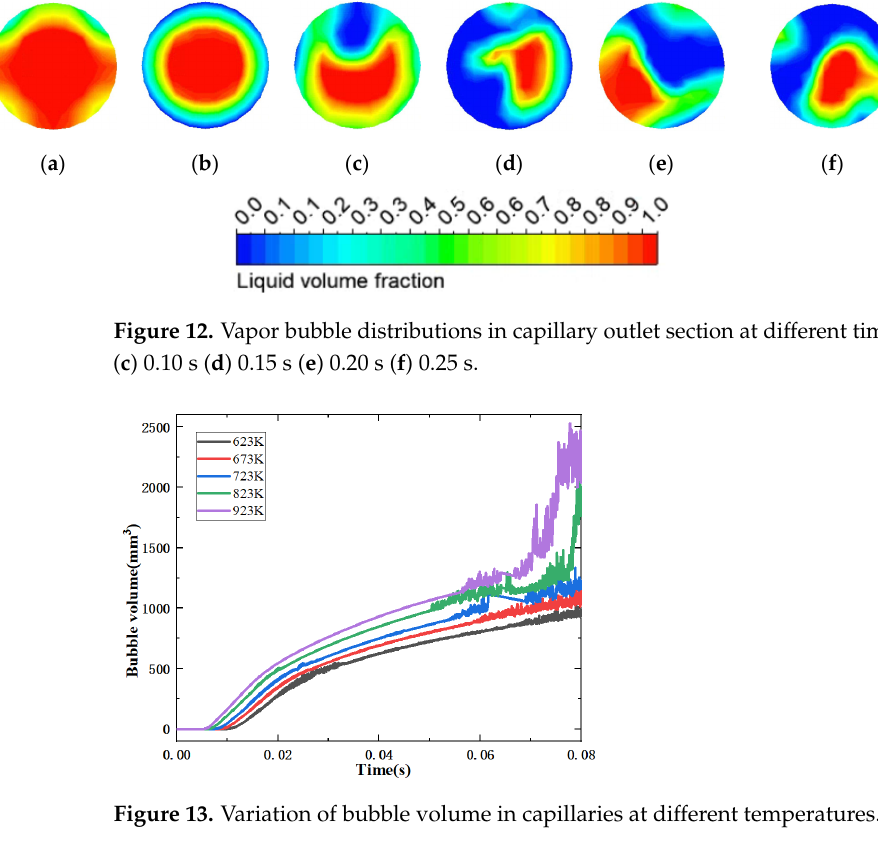
Figure 13. Variation of bubble volume in capillaries at different temperatures.